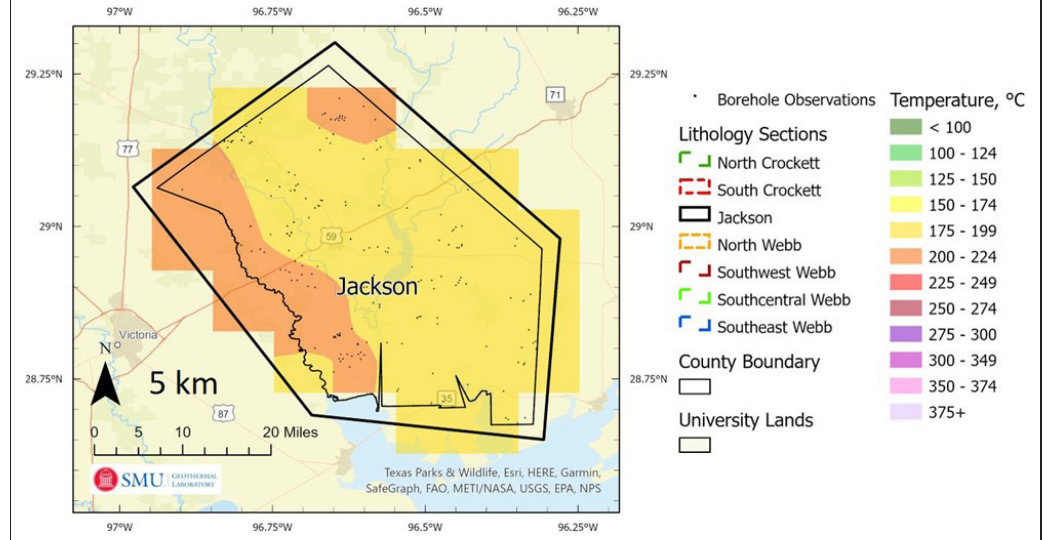
Figure 9. Temperature at 5.0 kilometers (km; 16,400 feet) depth in Jackson County, with data locations shown as small black dots, although most wells are this deep (Figure 1). This is the deepest temperature map with near direct temperature measurements to support the temperature gridding. At this depth, the whole county is above 150 °C (300 °F).